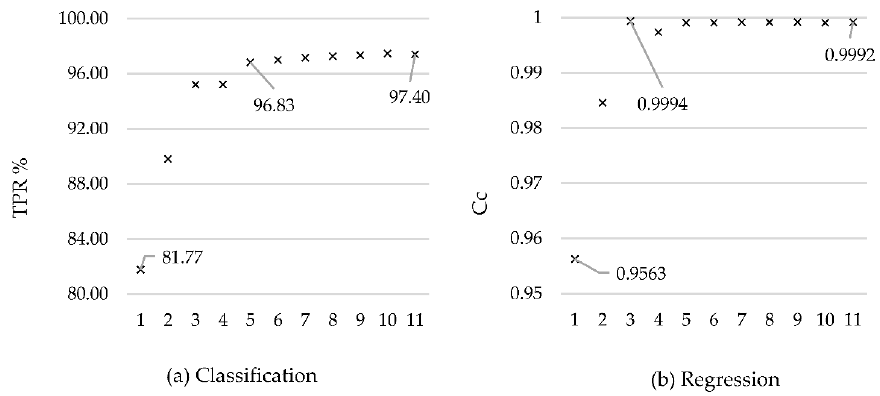
Figure 2. ( a ) Accurately classified instances (true positive rate (TPR)) and ( b ) correlation coefficients (Cc) for regression.